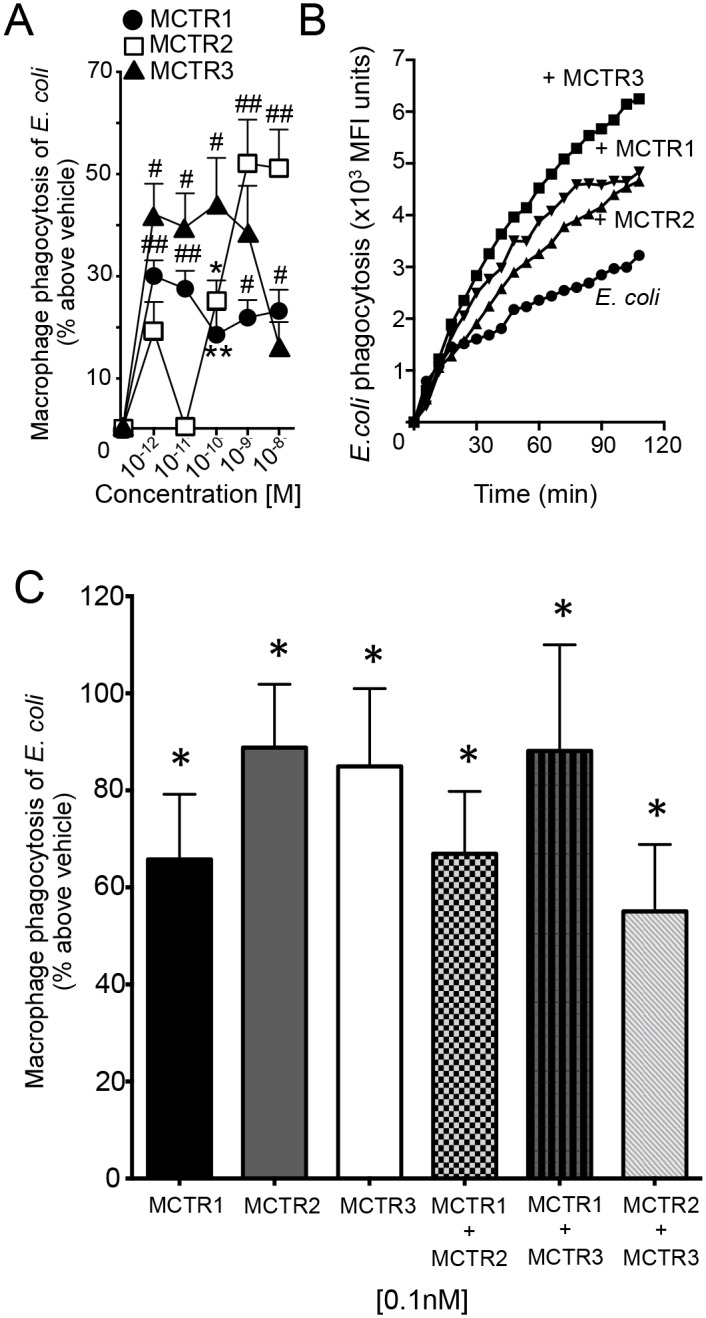
MCTRs are anti-inflammatory and pro-resolving with human phagocytes.Human macrophages (5 × 104 cells per well) were incubated with vehicle (DPBS+/+), MCTR 1, MCTR2 or MCTR3 (at the indicated concentrations, 15 min, 37°C). Fluorescently labeled (A) E. coli (n = 8) were then added and phagocytosis assessed after 60min using a fluorescent plate reader. Results are mean ± SEM. *p<0.05, **p<0.01, #p<0.001, ##p<0.0001 vs. vehicle. (B) Human macrophages were plated onto chamber slides (6 x104 cells/well) and incubated with MCTR1, MCTR2, MCTR3 (1 nM) or vehicle control (PBS+/+) for 15 min at 37°C, followed by addition of BacLight Green-labeled E. coli. Fluorescent images were recorded every 6 min for 120 min. In each experiment, 4 fields (20X) per condition (per well) were recorded. Results are mean fluorescence of 4 fields/well. n = 3 separate macrophage preparations. (C) E. coli phagocytosis by human macrophages incubated with MCTRs individually or the indicated combinations of MCTRs added simultaneously. Results are mean ± SEM for cells from n = 4 healthy human donors, *p<0.05 vs. vehicle (macrophages with E. coli alone).